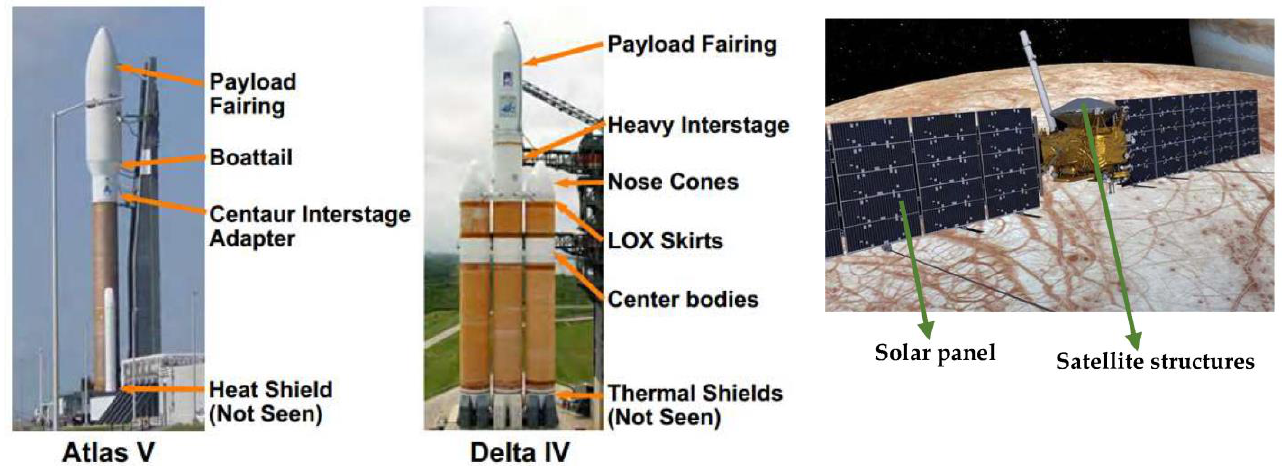
Figure 13. Schematic space vehicle (adapted with permission from Refs.